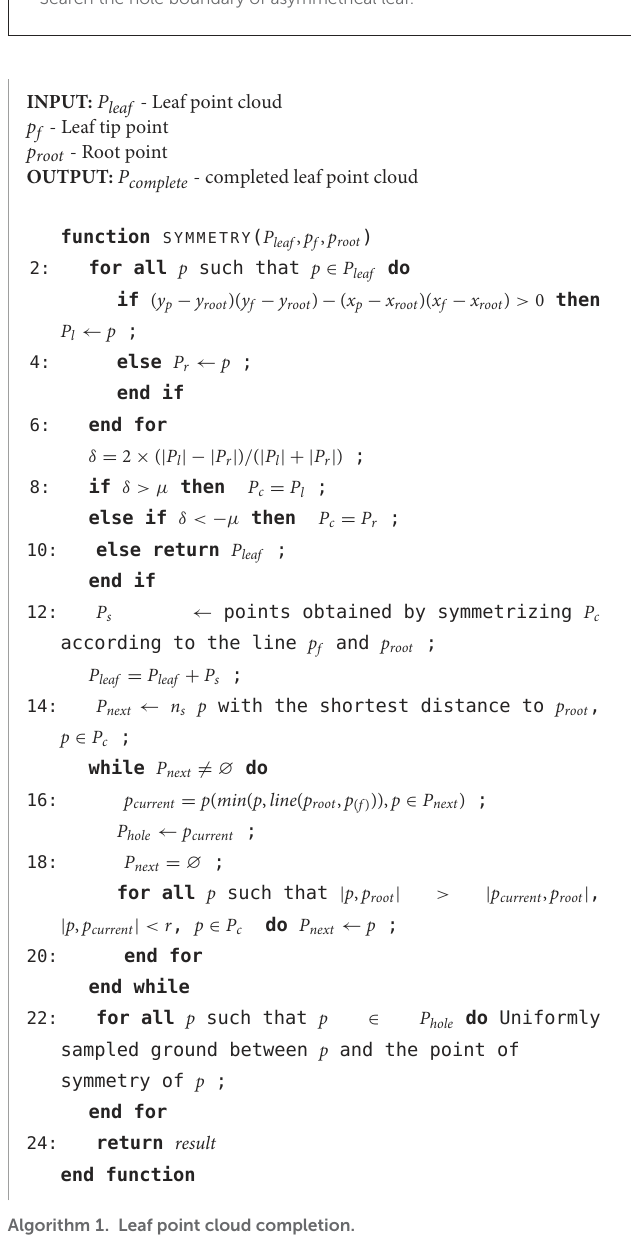
FIGURE6 Search the hole boundary of asymmetrical leaf.